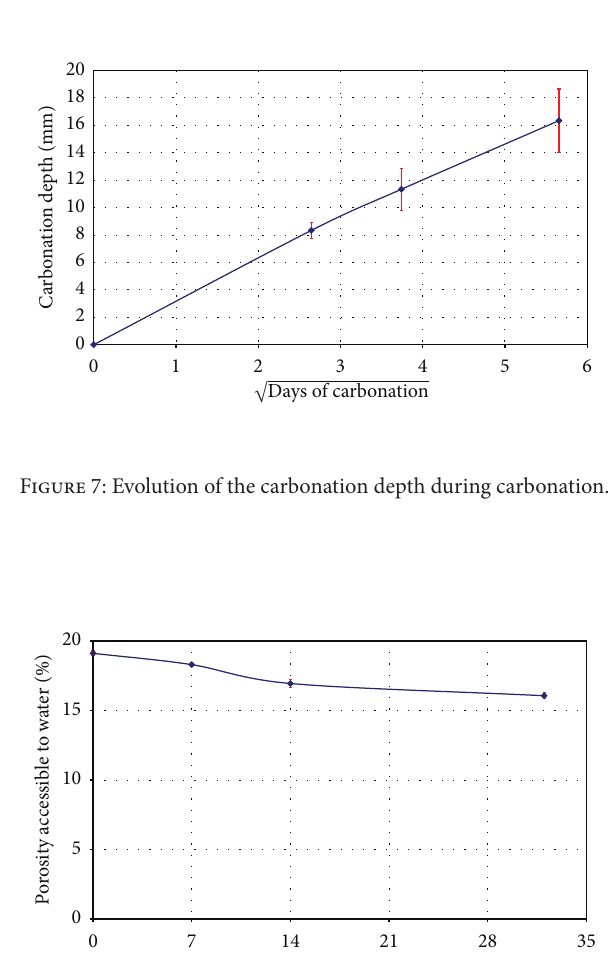
Figure 6: Propagation of CO 2 revealed by phenolphthalein test on samples carbonated for 7 days (a), 14 days (b) and 32 days (c).